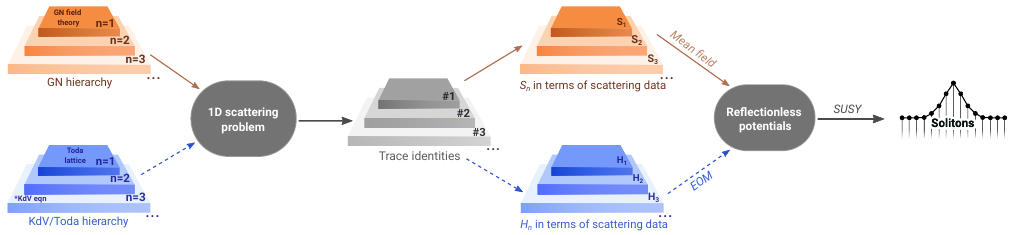
Figure 1 . A schematic depicting the sequence of steps used to generate a soliton hierarchy. We start with a hierarchy of field theories (the first of which is the Gross-Neveu field theory) or a hierarchy of dynamical systems/partial differential equations (the first in the Toda hierarchy is the Toda lattice, and the third in the KdV hierarchy is the KdV equation). The equations of motion of the GN field theory and a suitable change of variables for the KdV equation/Toda lattice map these seemingly unrelated systems to a one-dimensional scattering problem. With the help of trace identities derived in this scattering problem, we may rewrite either the action or the Hamiltonian in terms of scattering data, i.e. the reflection coefficient, the transmission coefficient, and the bound state energies of the scattering problem. There are also a hierarchy of trace identities, and each one uniquely maps onto one of the field theories or dynamical systems in the original hierarchies. The saddle point of the action corresponds to a reflectionless potential, and the equations of motion of the Hamiltonian systems imply the conservation of the magnitude of the reflection coefficient. In both cases, reflectionless potentials are either valid saddle points of the action or solutions to the dynamical system. These potentials are retrieved explicitly using supersymmetry methods, or more elaborately using the Gelfand-Levitan equation and the inverse scattering formalism.